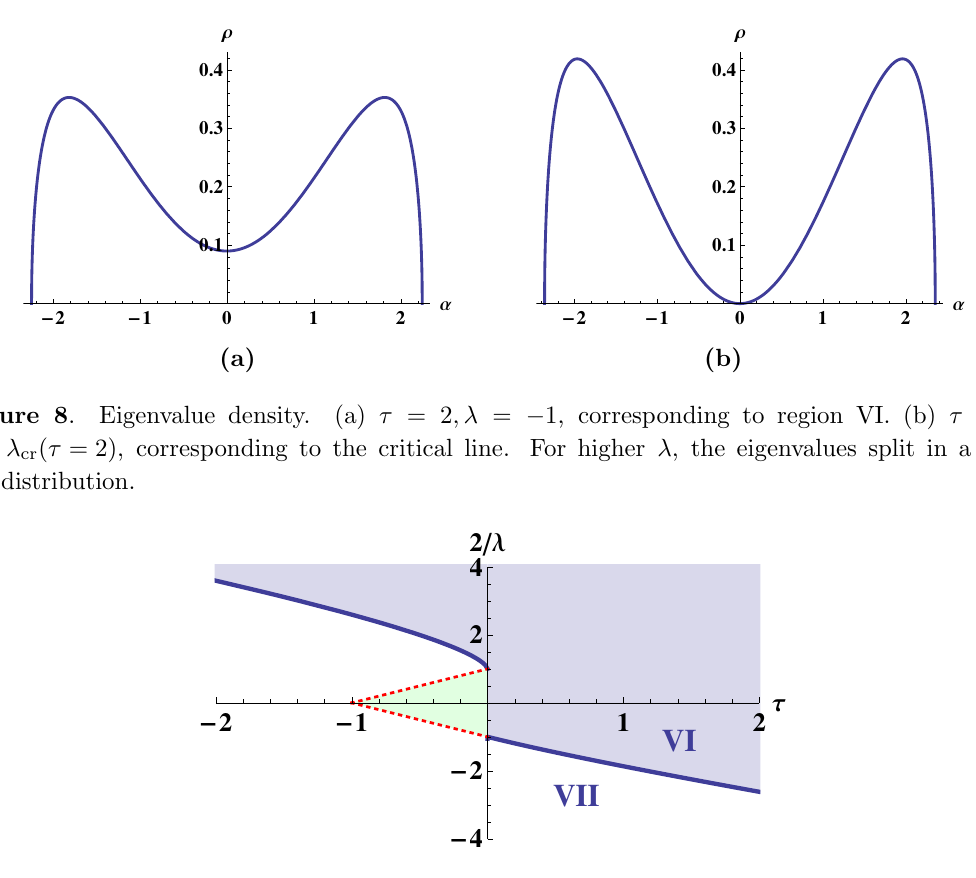
Figure 9 . Phase diagram. The gapped phase described by solution (3.6) exists in the grey shaded region. The green shaded area describes the region V where the ungapped phase solution (3.14) exists. Below the critical line (cid:21) cr in region VII there is a two-cut phase where eigenvalues accumulate at the two minima of the potential (cf. (cid:12)gure